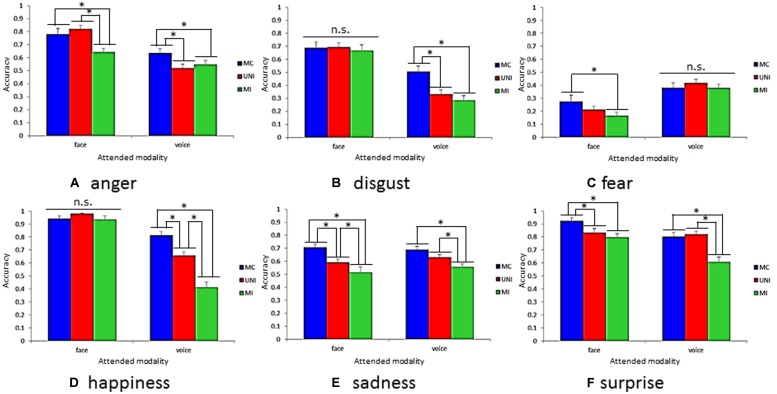
Accuracy on all presentation conditions for each emotion category with respect to attended modality. (A) anger, (B) disgust, (C) fear, (D) happiness, (E) sadness, and (F) surprise. Error bars represent SE. Asterisk indicate significant differences between presentation conditions (*p < 0.05).